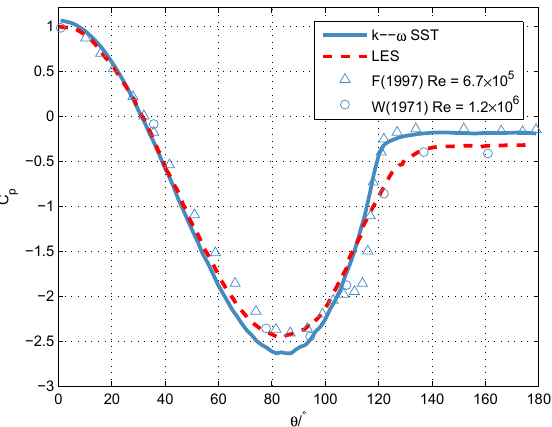
Figure 4. Pressure distribution around the cylinder compared with others’ simulation and experimental